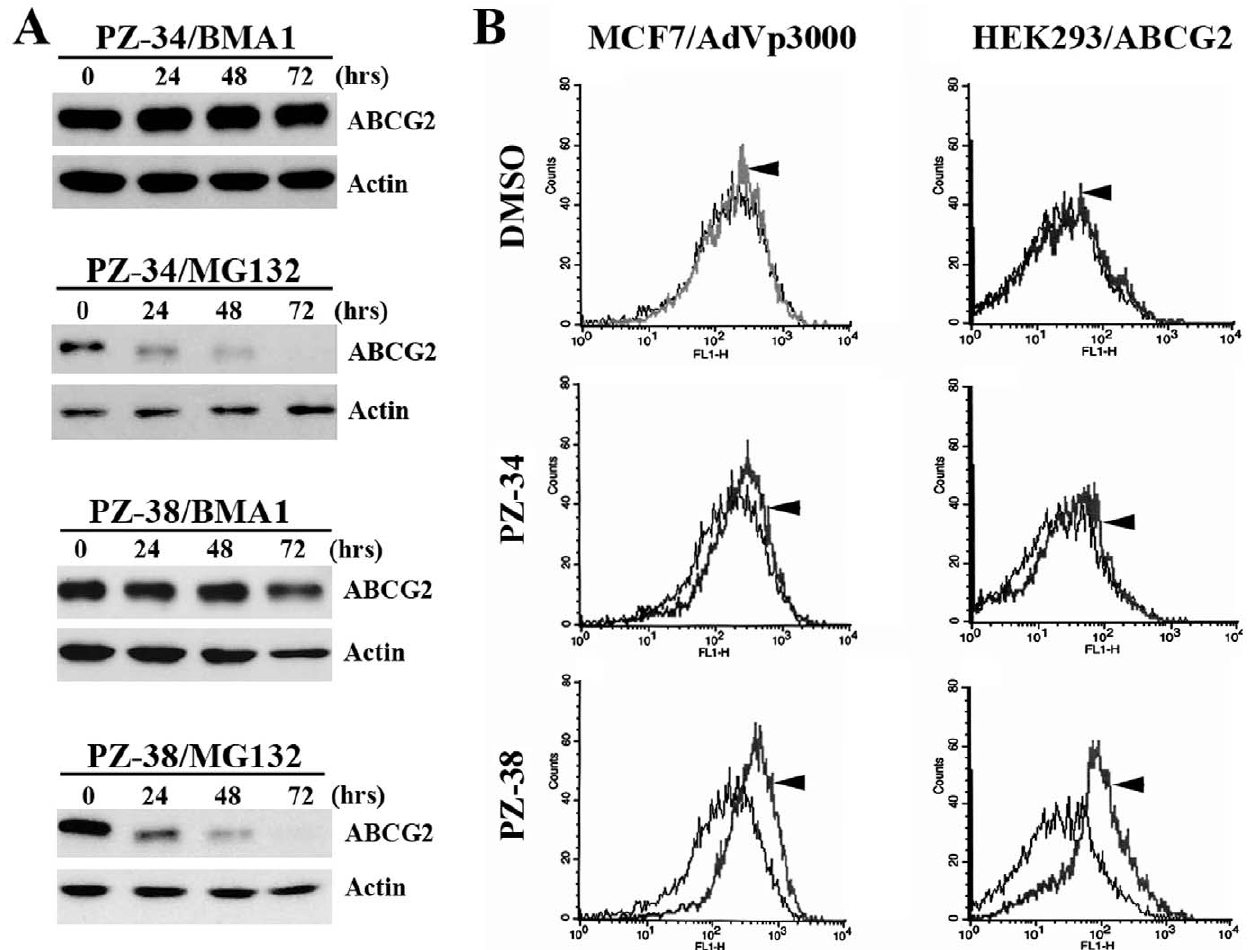
Figure 7. PZ-34 and PZ-38-binding induced ABCG2 degradation and conformational change. A, ABCG2 degradation in lysosomes. HEK293/ABCG2 cells were treated with 3 m M of PZ-34 or PZ-38 in the absence or presence of 10 nM Bafilomycin A 1 (BMA1) or 2 m M MG-132 for various times. The cells were then harvested for Western blot analysis of ABCG2 expression probed with monoclonal antibody BXP-21. Actin was used as a loading control. B, ABCG2 conformational changes. HEK293/ABCG2 and MCF7/AdVp3000 cells were treated with 10 m M of PZ-34, PZ-38, or DMSO vehicle control followed by staining with monoclonal antibody 5D3 and FACS analysis. Arrowhead indicate the PZ-34 and PZ-38 treated groups.